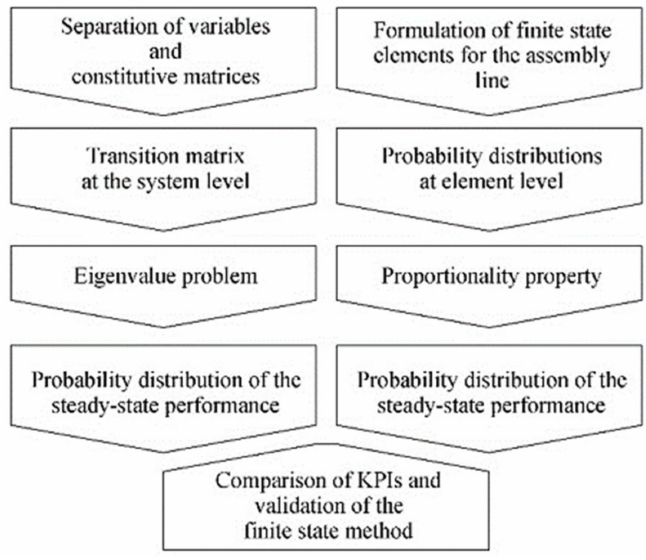
Figure 1. Mathematical modeling approaches and the workflow of the